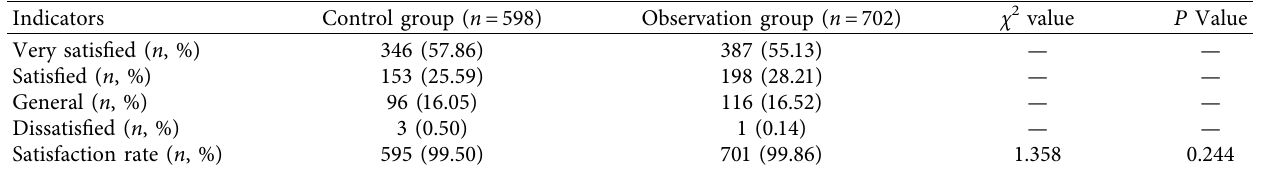
Figure 1: Comparative analysis of management treatment scores. Note: In the figure, A is the control group and B is the observation group. Figure (a) shows the management quality score, (b) shows the nursing level score, and (c) shows the nursing attitude score. ∗ is the comparison between the two groups, P < 0 . 05. Table 3: Analysis of patient satisfaction